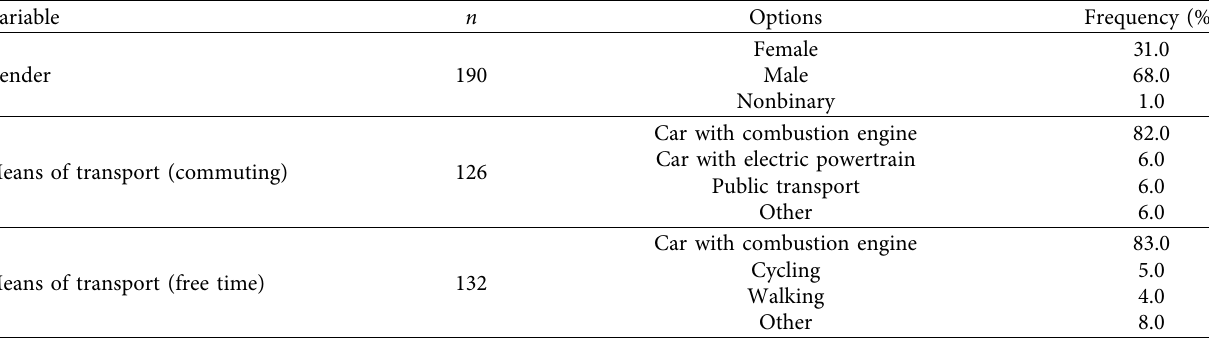
Table 2: Summary of sample characteristics from the